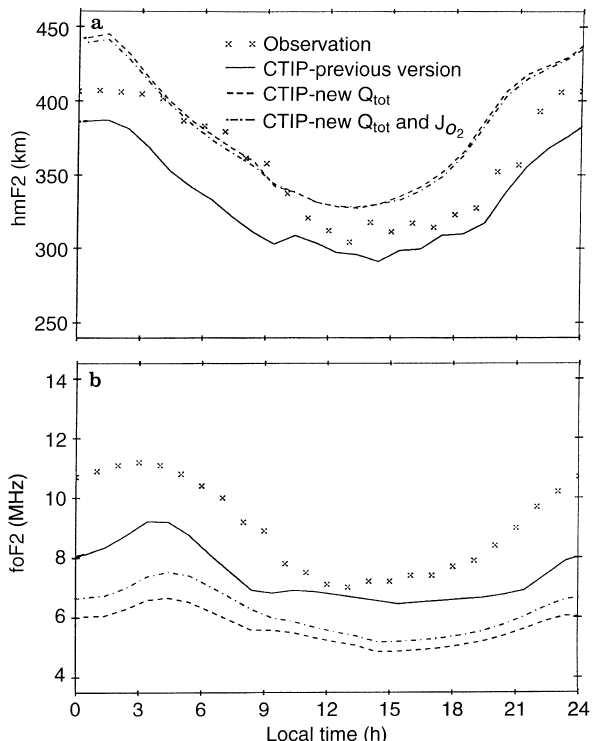
Fig. 1a,b. The effects of a new calculation of the solar heating and O 2 photodissociation rate on a hmF2 and b f oF2 over Argentine Islands for December solstice